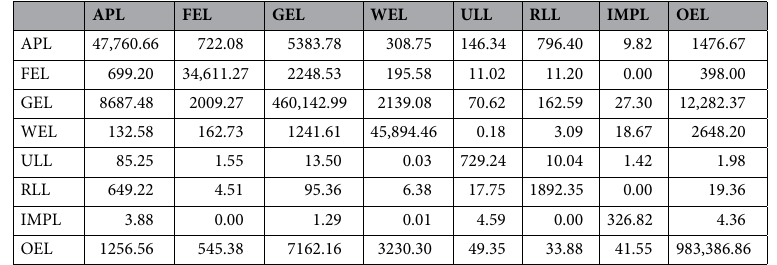
Table 3. Land use transition matrix in Xinjiang from 1980 to 2000 (km 2 ).